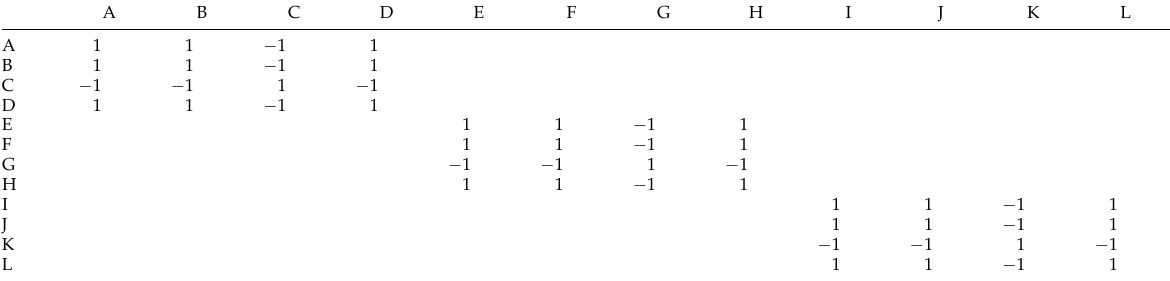
Table 2: Pearson correlations between simulated documents